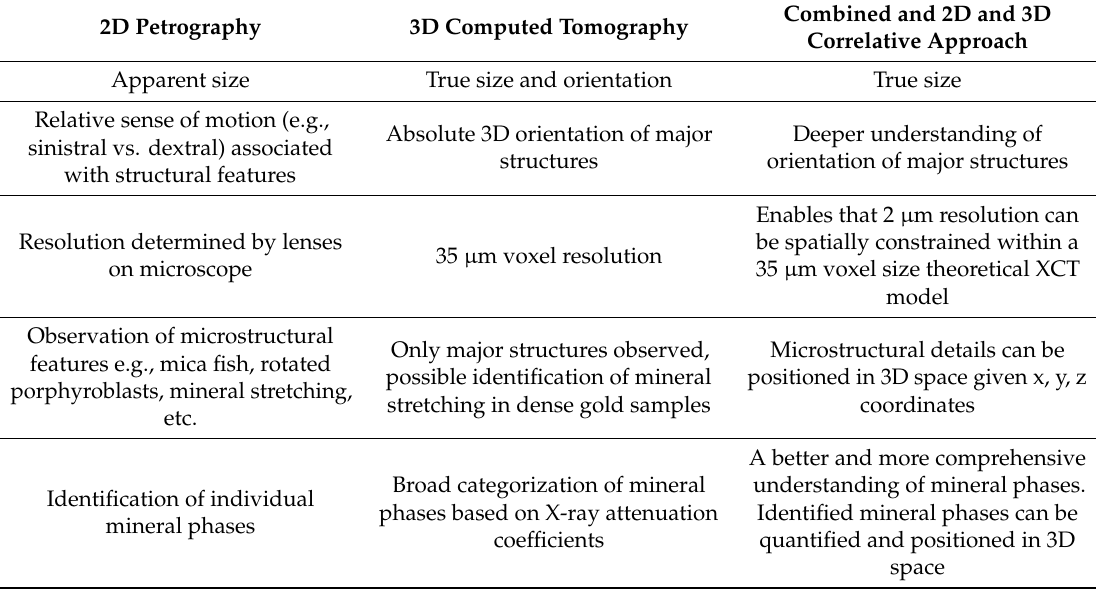
Table 4. Summary on information that can be obtained from combined